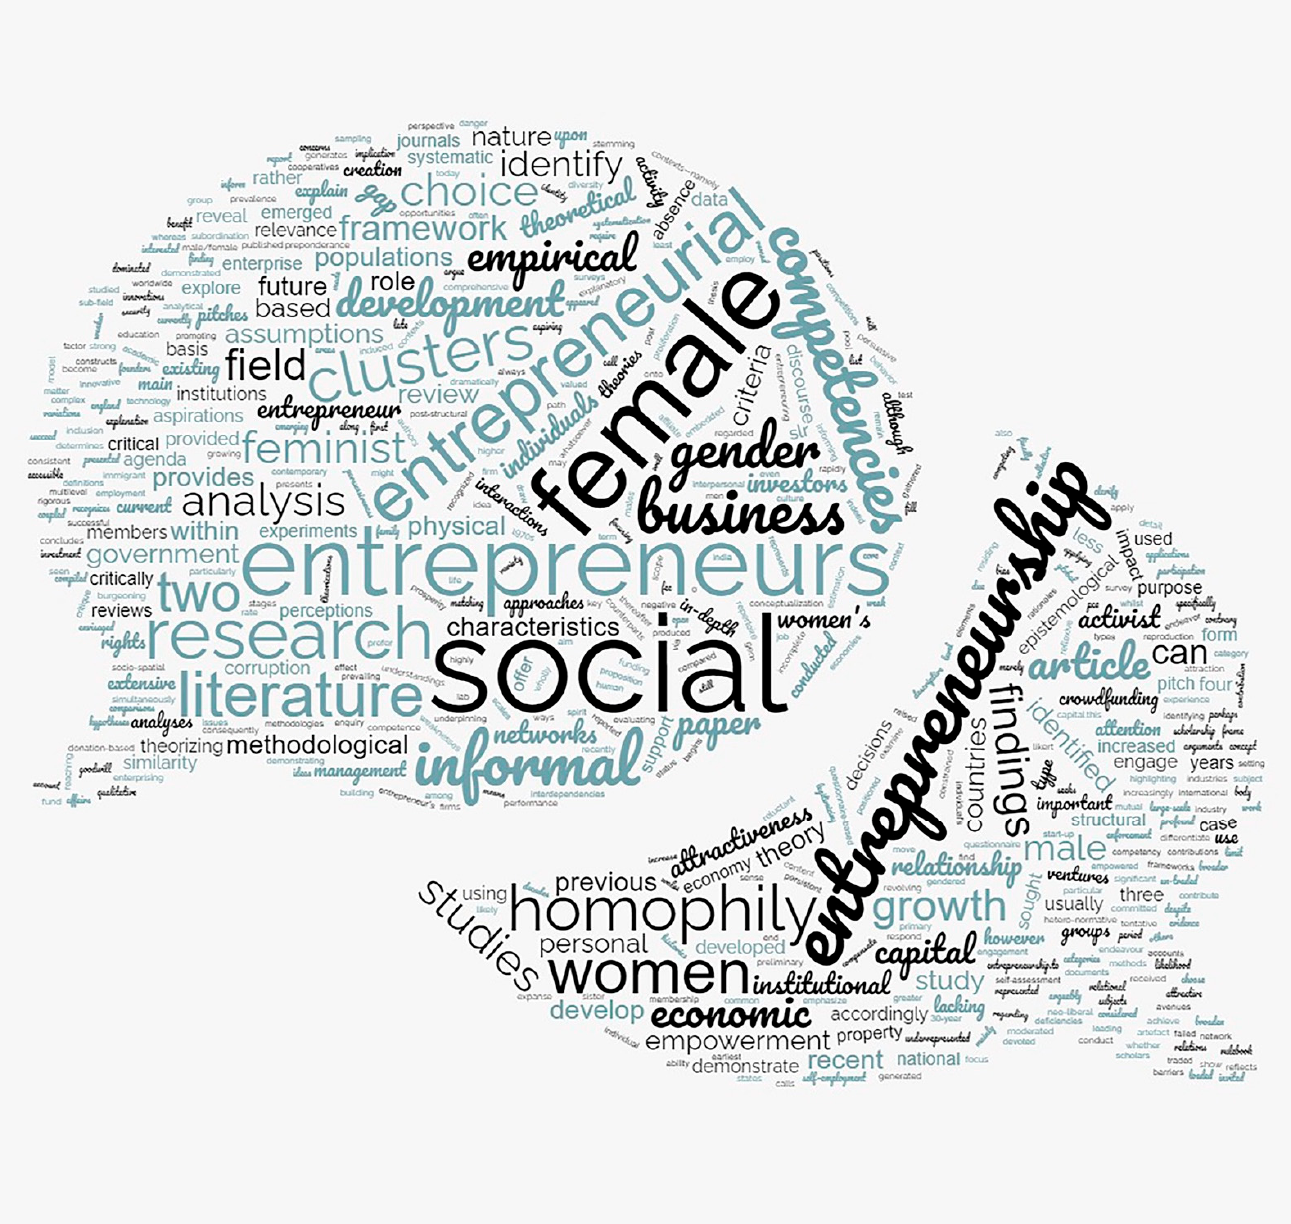
Figure 8. Word cloud of terms